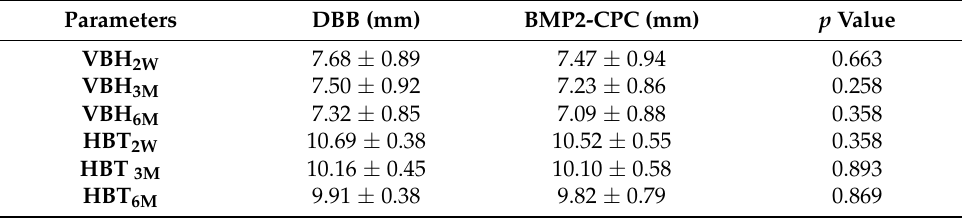
Figure 1. Clinical radiographic evaluation results. ( a ) Representative postsurgical CT images of each group; ( b ) measurement of the postsurgical VBH and HBT values; ( c ) reduction values of the postsurgical VBH and HBT of each group; ( d ) reduction rates of the postsurgical VBH and HBT of each group. Table 1. Measurement